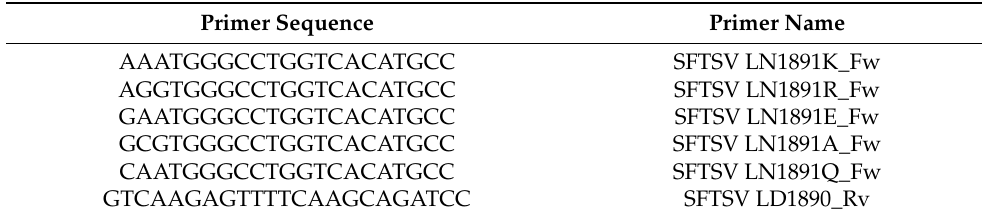
Table 1. Primers used for the construction of the L protein